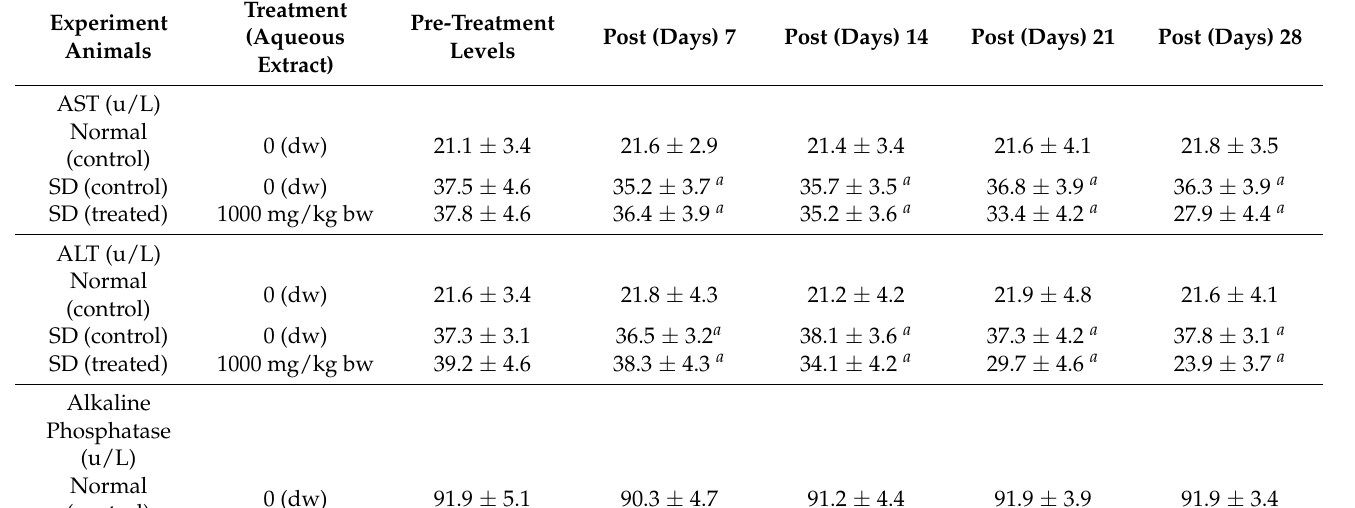
Table 6. Effect of graded dose of t. dioica leaves aqueous extract on serum enzymes, total protein, and total hemoglobin of severely diabetic (SD) rats (mean ± s.d.) for pre- and post-treatment